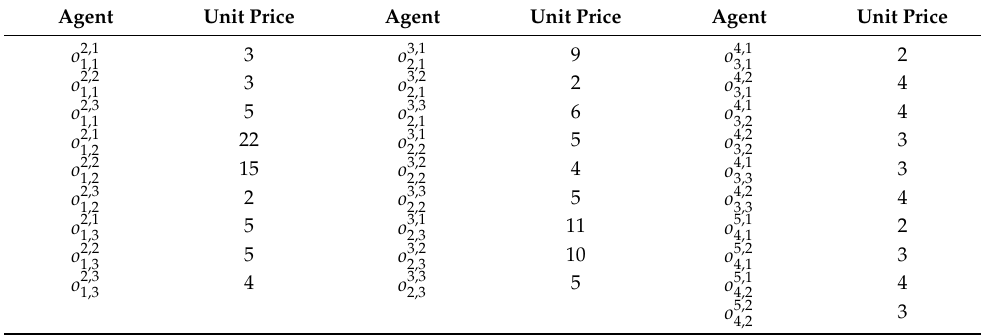
(cid:48) ( (cid:164) /ton) for the other costs from a l + 1, v (cid:48) to a l , v . l , v